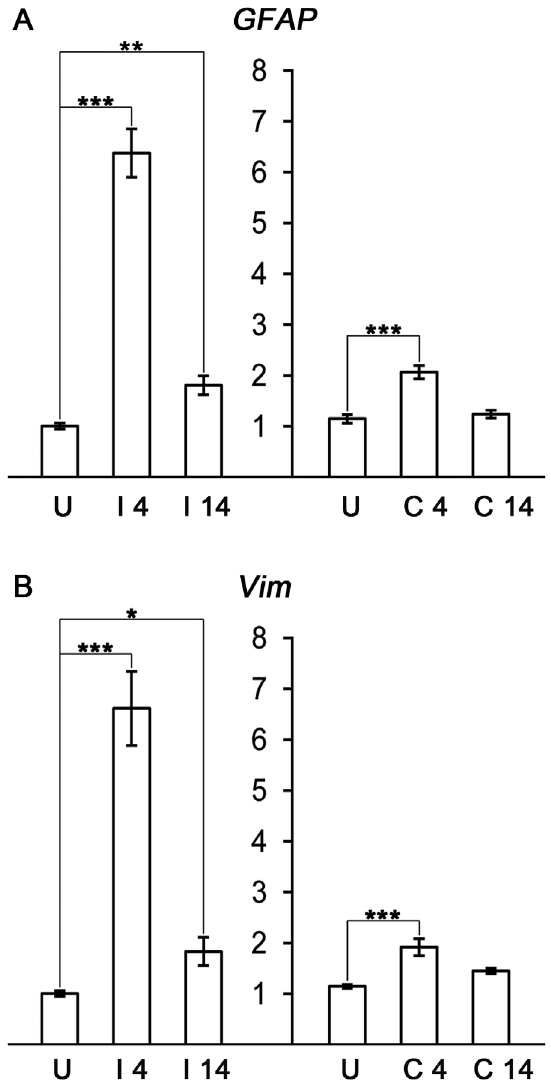
Figure 1. GFAP and Vim upregulation after ECL at the injured and contralesional side. (A) GFAP and (B) vimentin ( Vim ) mRNA is upregulated in the hippocampal tissue at the injured side (I) at both 4 and 14 days after injury and at the contralesional side (C) at day 4. U, uninjured control; * p , 0.05; ** p , 0.01; *** p , 0.001.